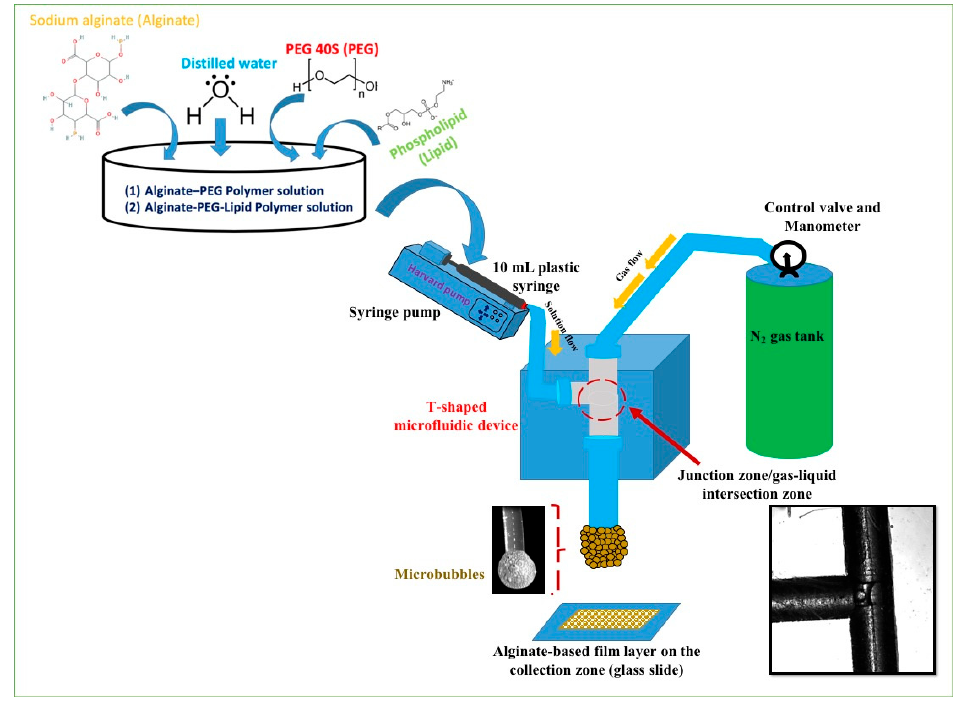
Figure 1. Schematic representation showing the T-shaped microfluidic junction processing of an alginate-based porous film formation from bubble bursting used in this experimental work.